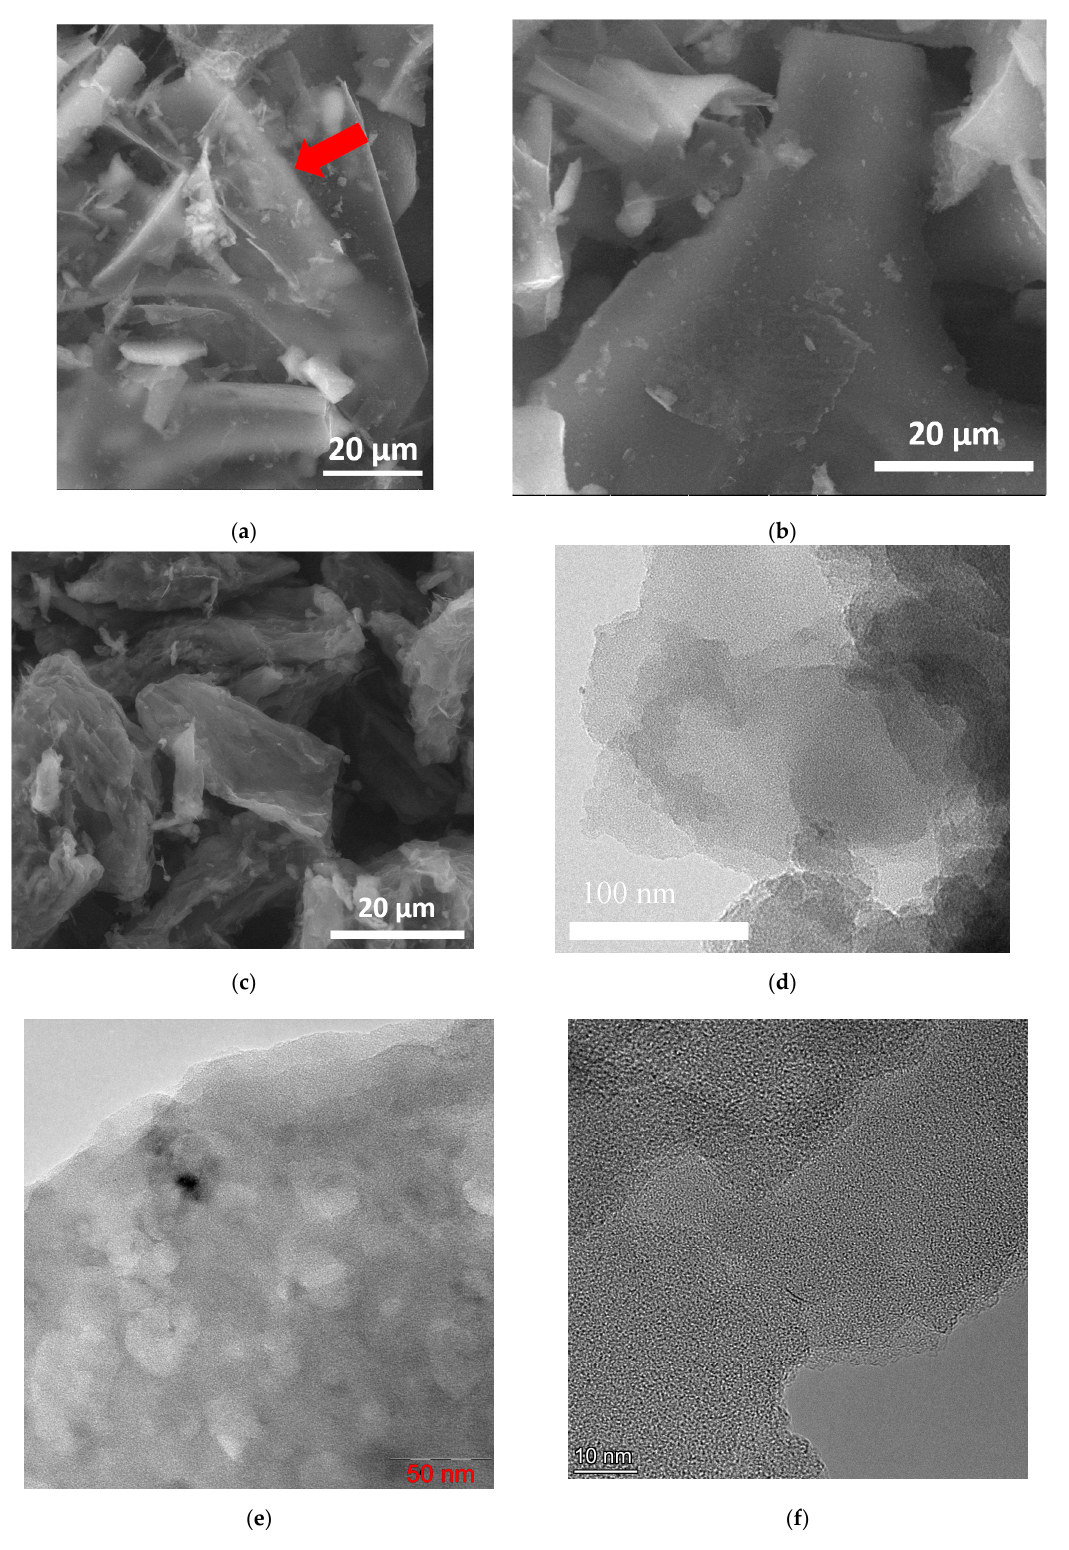
Figure 3. SEM and TEM images of synthesized FLG nanosheets. ( a – c ) SEM images—sample synthe ‐ sized from glucose, starch, and cellulose respectively. Linear scale: a–c—20 μ m; ( d – f ) TEM images— sample synthesized from glucose, starch, and cellulose respectively. Linear scale: d—100 nm, e—50 nm and f—10 nm. The red arrow marks a particle that is visible through a sheet of few ‐ layer gra ‐ phene.